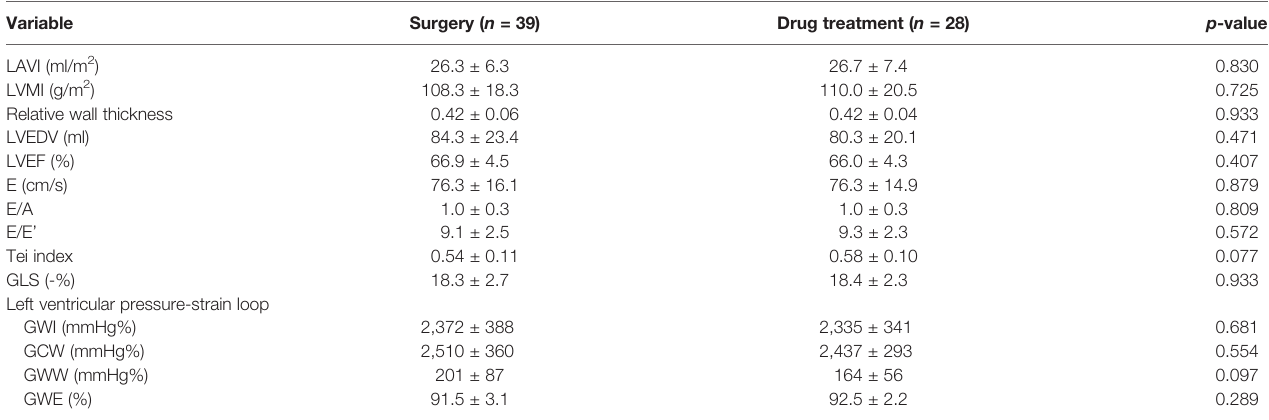
TABLE 2 | Echocardiographic measurements at baseline.